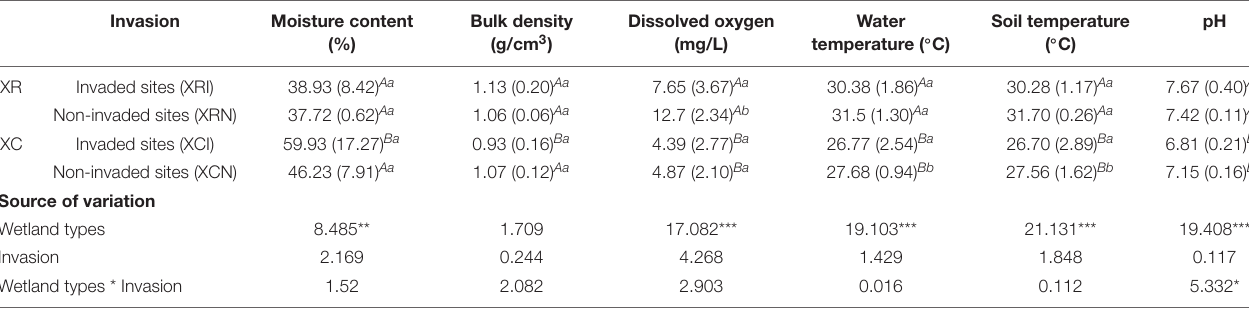
TABLE 1 | Soil physicochemical properties (mean, SD) in Xinxue River (XR) and Xinxue River Constructed Wetland (XC).